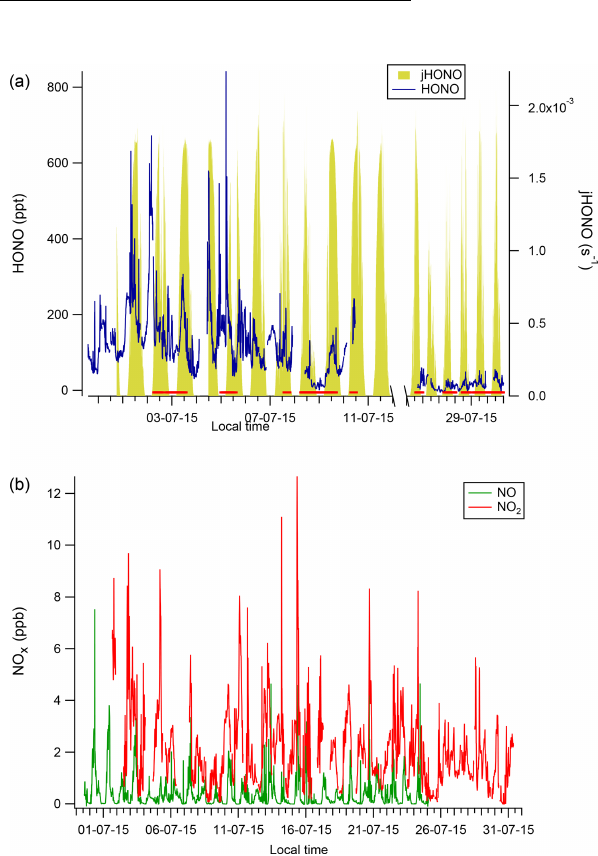
Figure 1. Time series of the measured HONO, j HONO (a) and NO x (b) mixing ratios at CVAO.